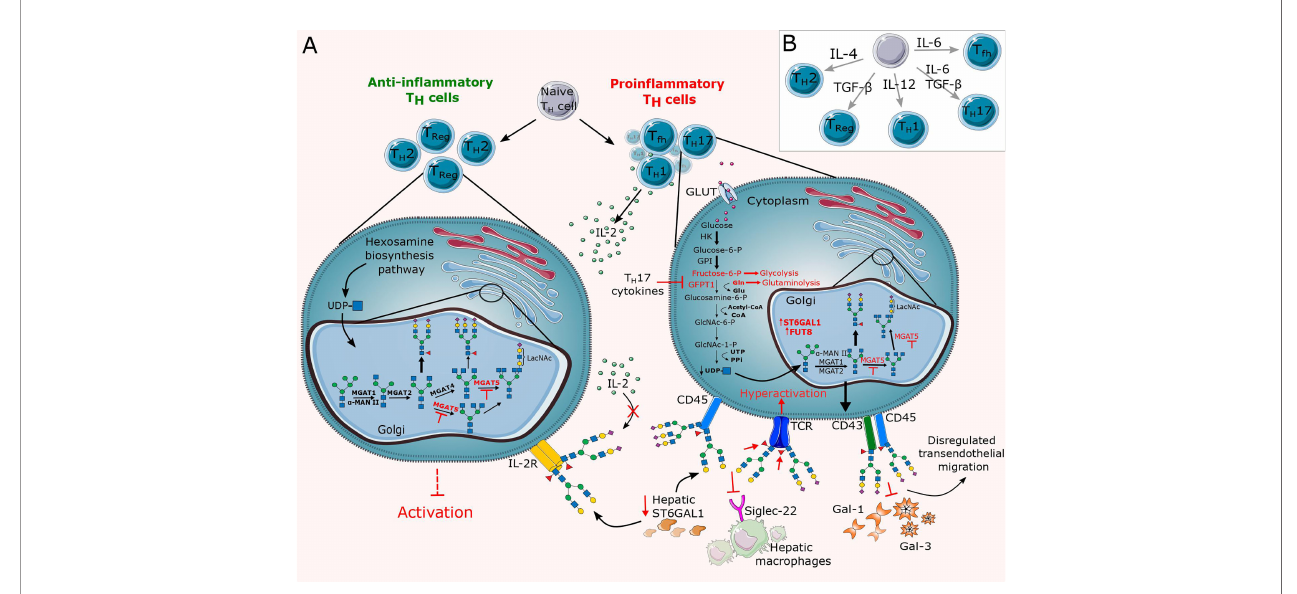
FIGURE 4 | Overview of altered N-glycosylation pathways regarding T cells during chronic in fl ammation. (A) Differentiation of lymphocytes and thus their surface N-glycome is under the direct in fl uence of cytokines and stimulation by antigen presenting cells (APCs). Cytokines control differentiation in favor of proin fl ammatory T cells (Th1, Th17, Tfh), thereby altering their N-glycome by dysregulating the expression of glycosyltransferases such as MGAT5, ST6GAL1 and FUT8 and abrogating substrate availability for the hexosamine biosynthesis pathway (HBP). The resulting N-glycan changes signi fi cantly reduce the binding af fi nity of inhibitory galectins and Siglecs. (B) Schematic representation of the relevant cytokines responsible for the T cell differentiation. GLUT, glucose transporter; TCR, T cell receptor; Tfh, T follicular helper cell; Th, T helper cell; Treg, T regulatory